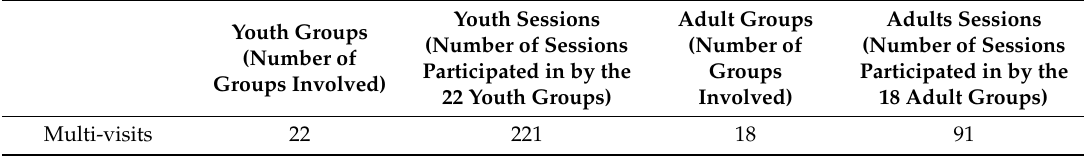
Figure 1. TheWestonbirtArboretum, Gloucestershire, Englandshowingthe‘park-like’woodlandlandscape. Table 1. The total number of youth and adult groups involved in the Community Project multi-visits and the number of sessions they were involved